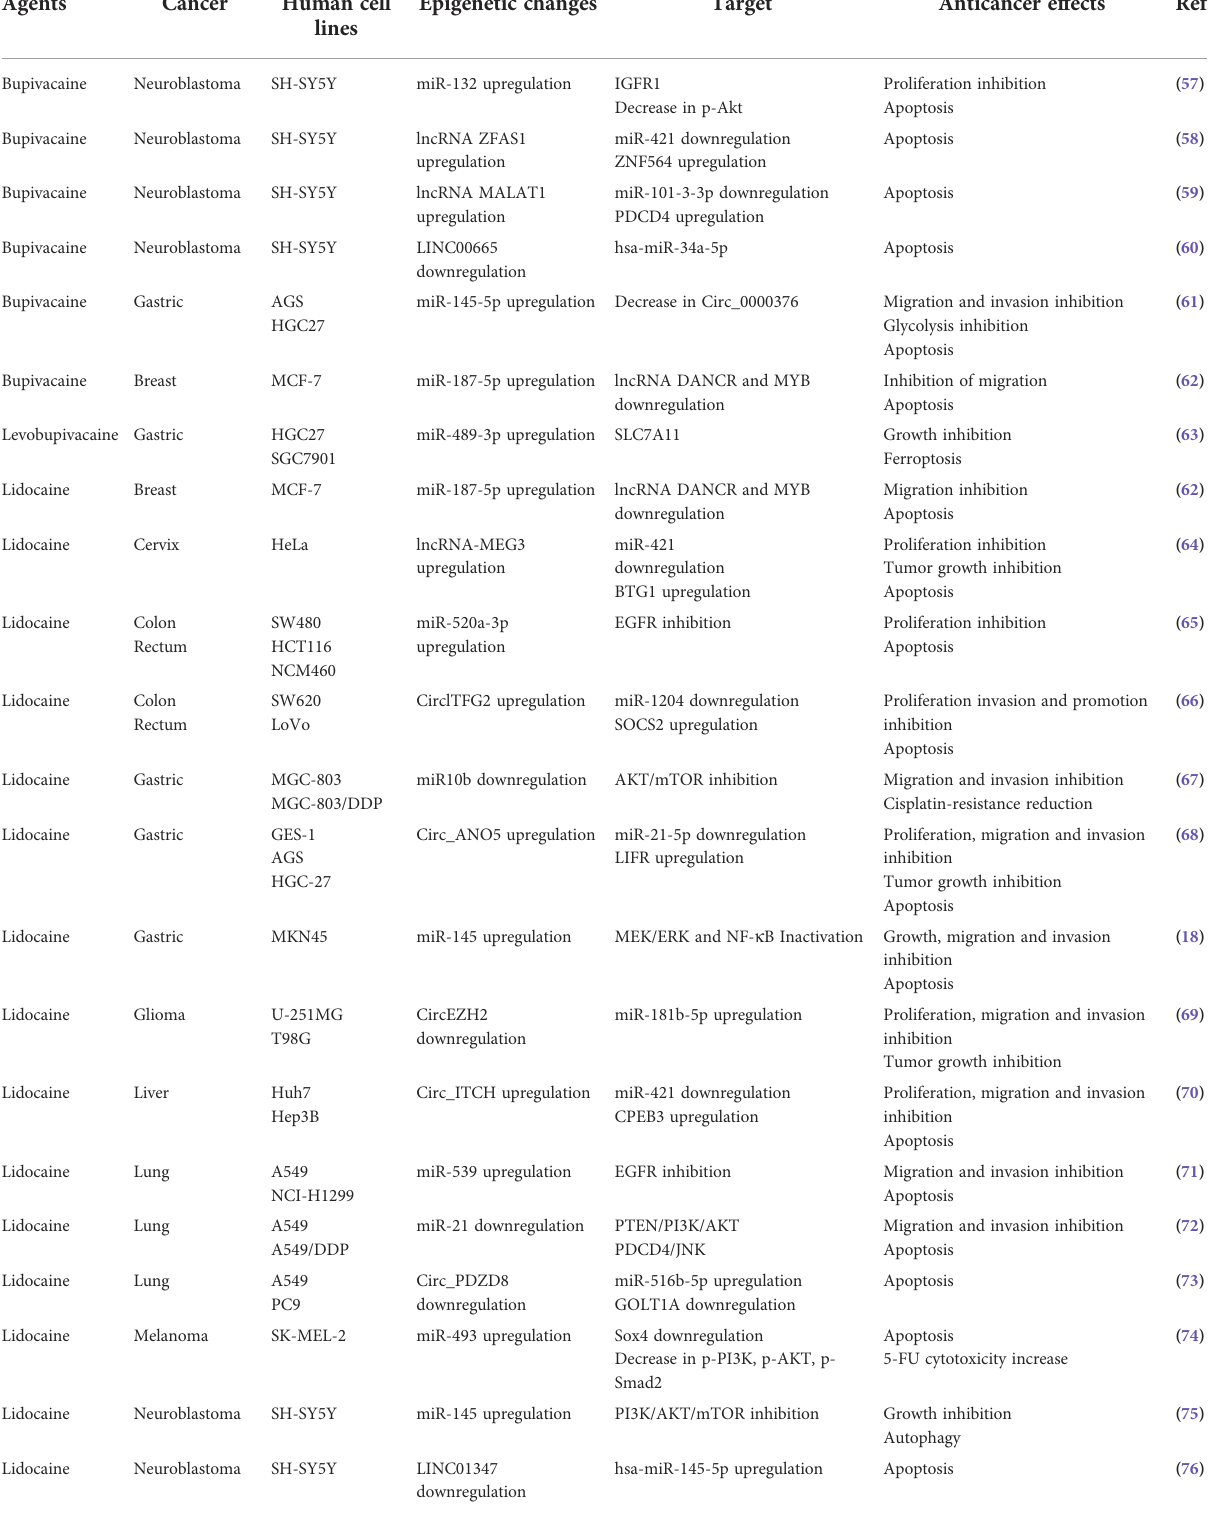
TABLE 2 Local anesthetics and non-coding RNAs